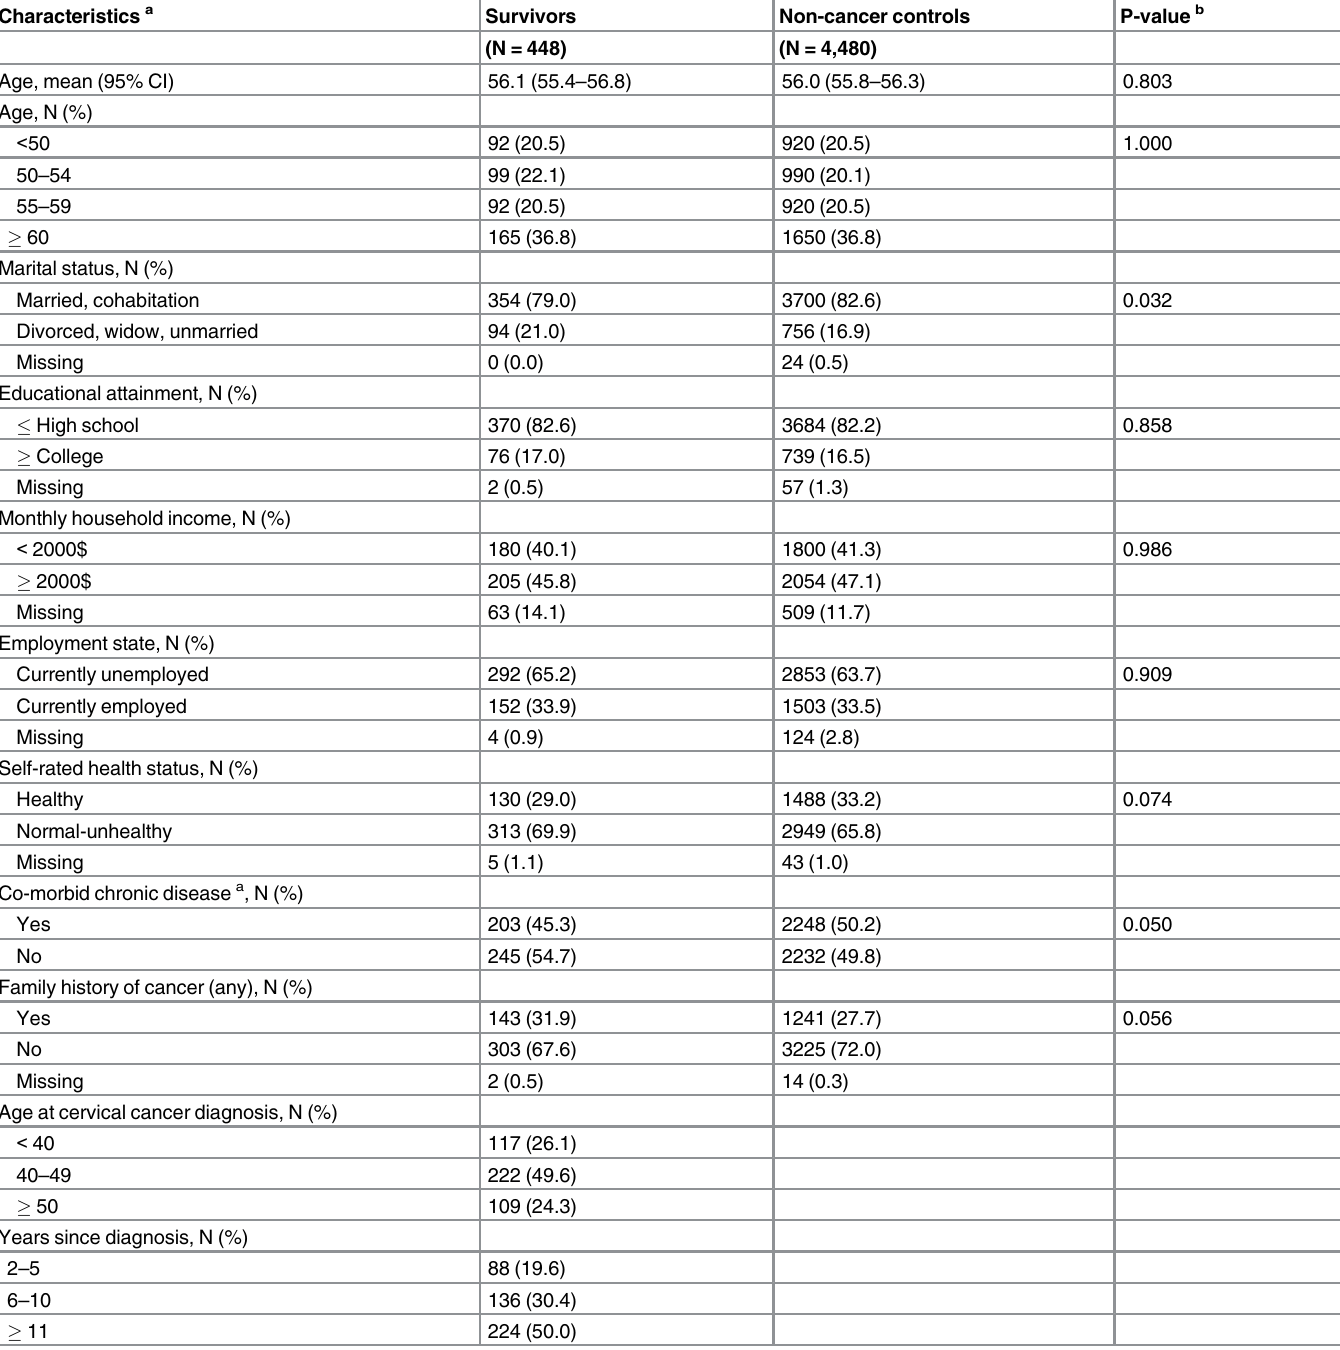
Table 1. Comparison of basic characteristics between cervical cancer survivors and female respondents never diagnosed as having